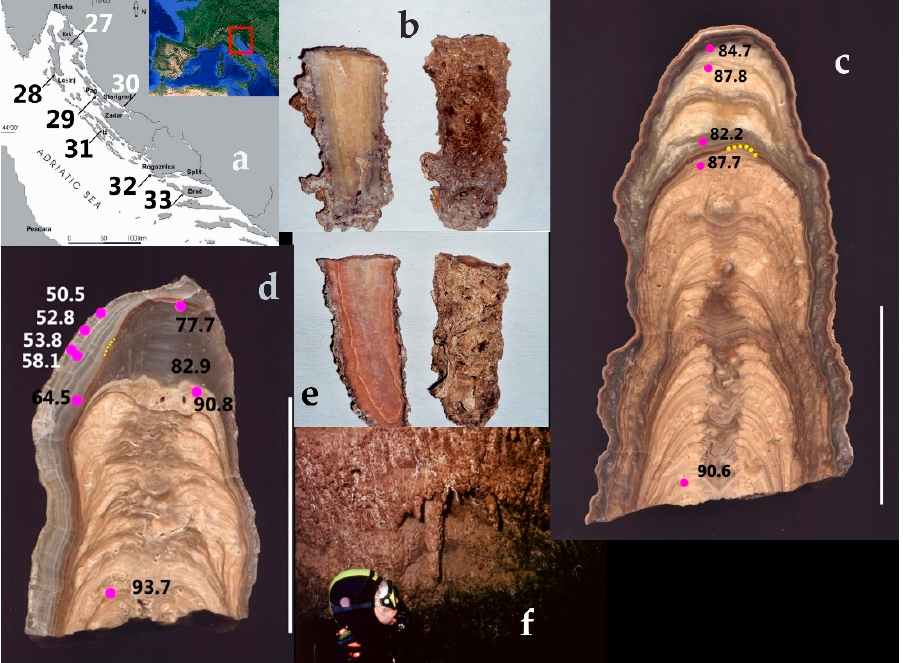
Figure 3. Coastal caves and submerged speleothems from Croatia. ( a ) Map of the Adriatic Sea showing the locations of the Croatian caves [21]. ( b ) Stalactite P-23, with overgrowth, from a cave in Tihovac Bay (Pag Island) − 23 m. ( c ) Stalagmite K-14 from U vode Pit (Krk Island) at − 14.5 m. Pink dots represent the portions of the speleothem collected for U-Th dating, and yellow dots are the areas where X-ray diffraction analyses were conducted by [3] to identify the hiatus between 87 and 82 kyr. ( d ) Stalagmite K-18 from U vode Pit (Krk Island) at − 18.8 m. Pink dots represent the portions of the speleothem collected for U-Th dating, and yellow dots are the areas where X-ray diffraction analyses were carried out by [3] to identify the hiatus between 77.7 and 64.5 kyr. ( e ) Stalactite R-21 from Zmajevo uho Pit at − 21.1 m. Photo by M. Suri ć . ( f ) Cave near Iški Mrtovnjak. Photo by M. Kvarantan.